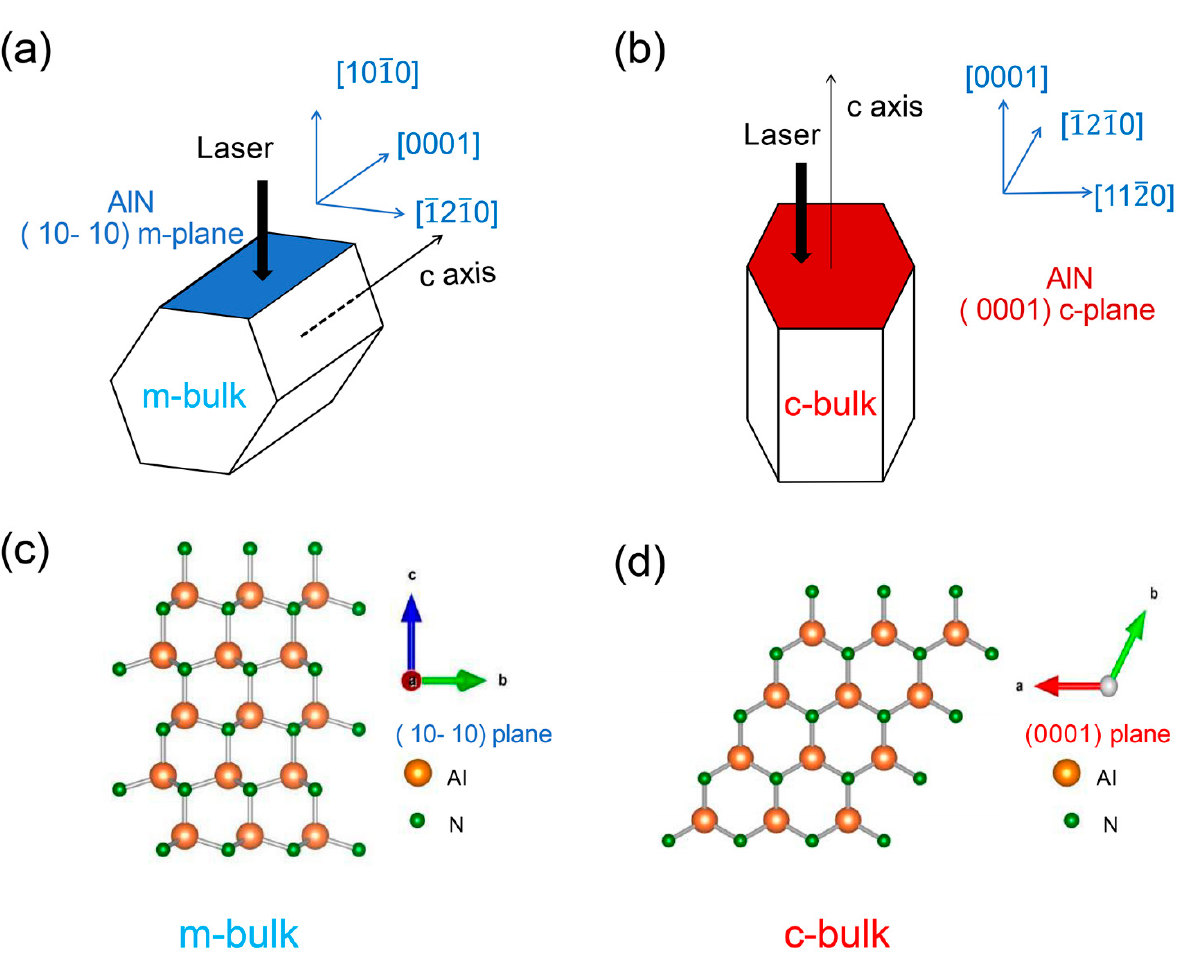
Figure A1. Schematic diagrams of Raman experiments of the m-bulk sample ( a ) and the c-bulk sample ( b ). ( c ) Top view of the crystal structure of the m-bulk AlN crystal in the (10-10) plane perpendicular to the c-axis and ( d ) top view of the crystal structure of the c-bulk AlN crystal in the (0001) plane parallel to the c-axis.